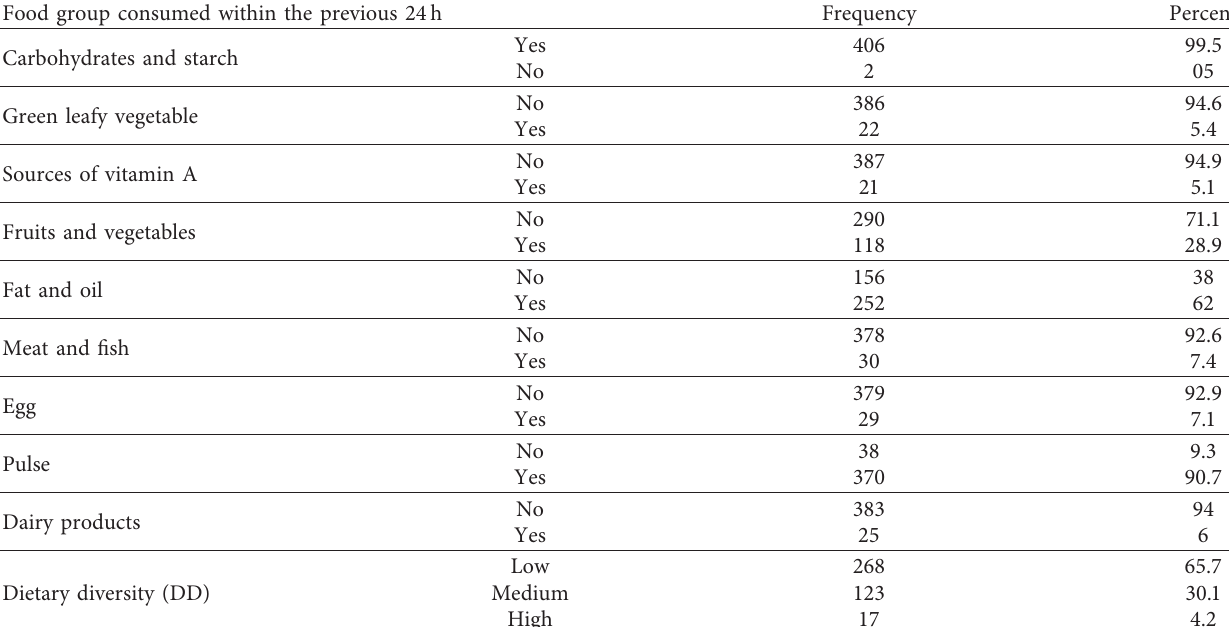
Table 3: Dietary diversity frequency of lactating mothers ( n � 408) in Lay Gayint District, South Gondar Zone, Ethiopia, March 2018. Food group consumed within the previous 24h Carbohydrates and